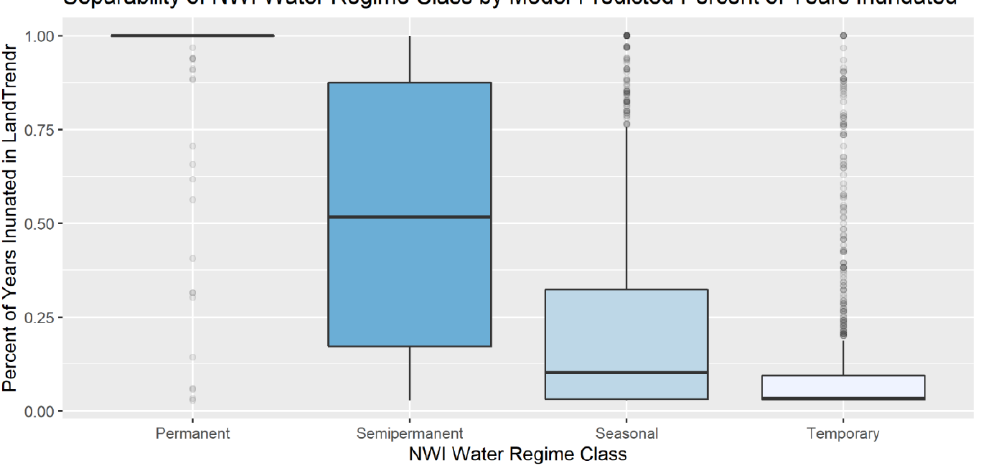
Figure 10. The separability of NWI Water Regime class by percent of years inundated predicted by LandTrendr. A set of 4000 random points were sampled within the NWI for Minnesota, with 1000 points per water regime class. The distribution of percent of years inundated as predicted by LandTrendr is plotted by water regime class. Note that the different water regime classes have significantly different distributions of predicted frequency of inundation (Kruskal – Wallis test p -value: 2.2 × 10 − 16 ), suggesting that changes in LandTrendr predictions could be associated to changes in water regime class.